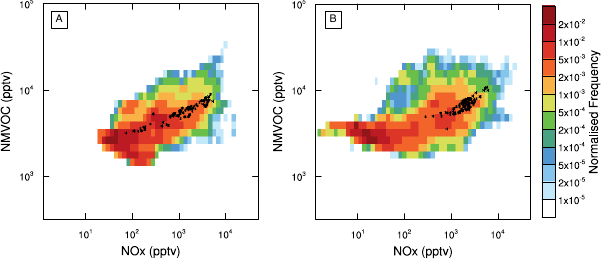
Figure 4. Two-dimensional histogram illustrating the NMVOC:NO x chemical space across the model domain (at 960hPa pressure level) during the periods of flights B535 (a) and B541 (b) . Data frequency is normalised to the total number of grid cells sampled. Model data extracted along the flight tracks are represented by black